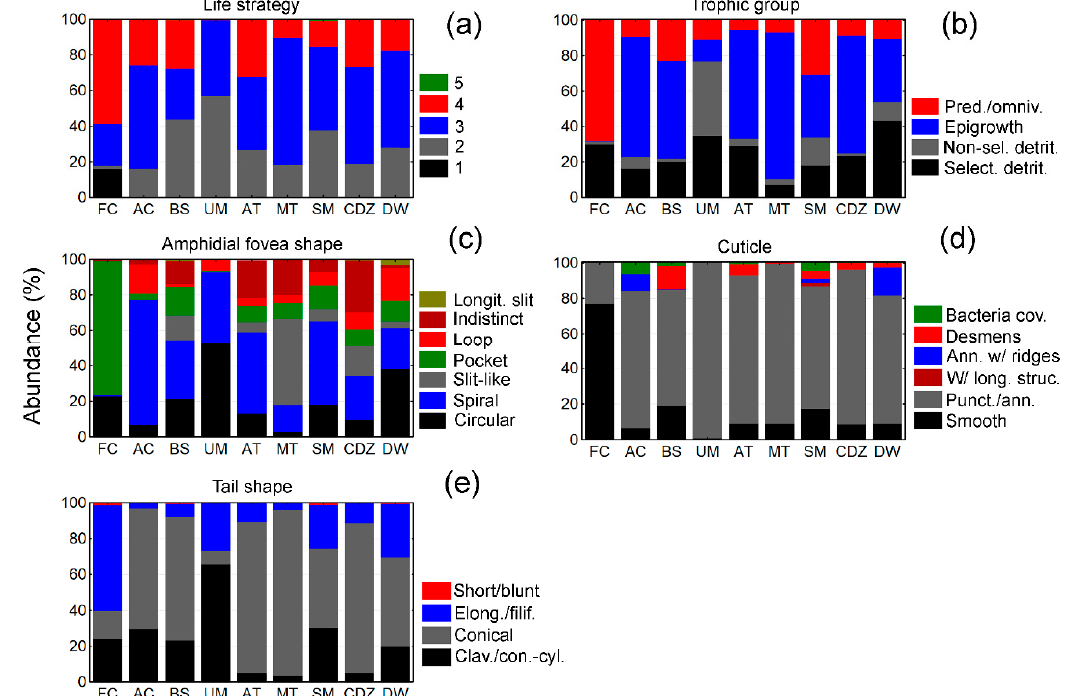
Figure 5. Biological traits of nematode assemblages across nine habitats. ( a ) Life strategy scale